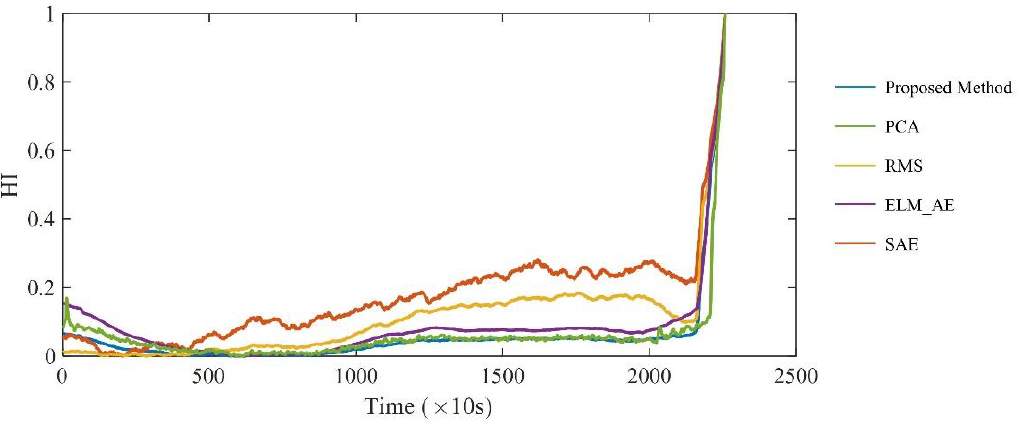
Figure 10. HI curves constructed based on five methods.